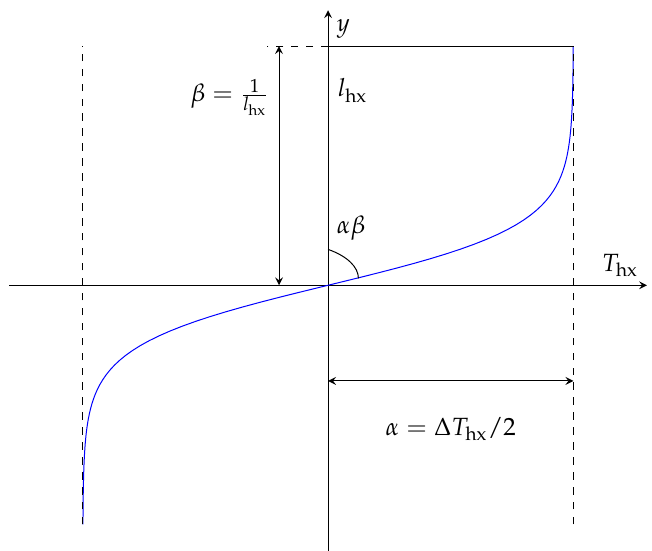
Figure 2. Non-linear temperature profile along the inner surfaces of the heat-exchanger walls, showing a temperature saturation at long lengths from the origin (equilibrium position mid-way between the hot and cold heat